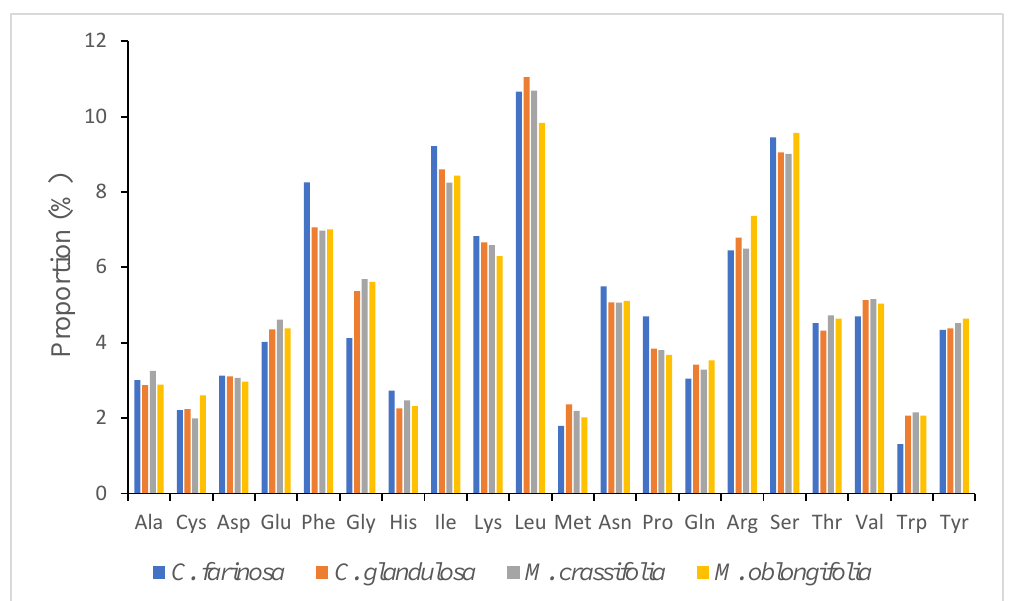
Figure 2. Amino acid frequencies in the four Capparaceae chloroplast genomes’ protein-coding sequences.